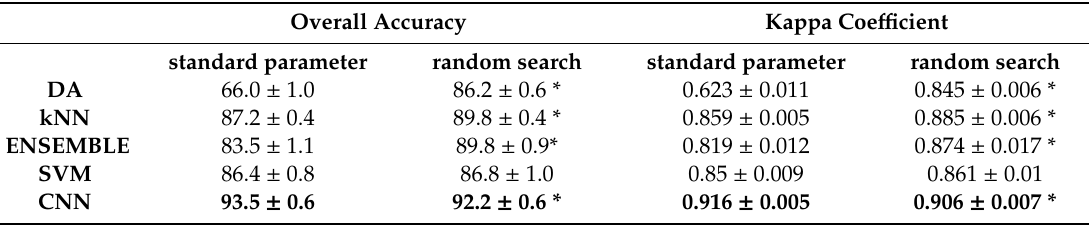
Table 1. Comparison of the obtained average overall classification accuracies and kappa coe ffi cients with confidence intervals ( α = 0.05) of the experiments with all 12 black plastics, with and without hyperparameter optimization. The best overall classification accuracy is shown in bold. The asterix (*) shows a statistically significant di ff erence between the models trained with standard parameters and the models trained with RS (calculated with ANOVA, α = 0.05). Overall